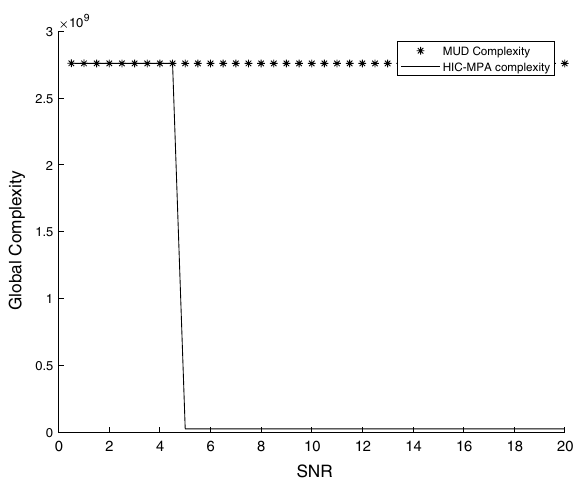
5 for non optimal Ŵ 10 − =